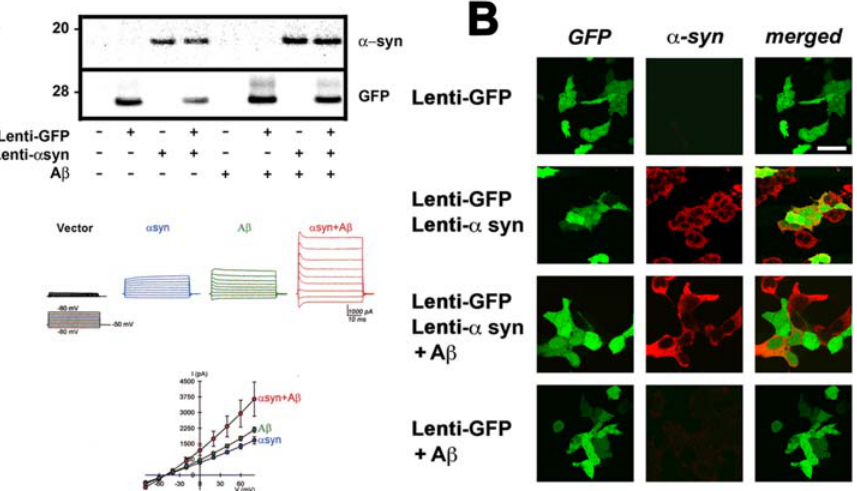
Figure 7. Electrophysiological analysis of the cellular effects of hybrid A b / a -syn multimers. 293T cells were infected with lenti- a -syn and lenti-GFP and treated with A b and analyzed by electrophysiology. ( A ) Immunoblot analysis showing expression levels of a -syn and GFP in treated cultures. ( B ) Immunocytochemical analysis demonstrating high efficiency of infection and co-localization between a -syn and GFP. ( C, D ) Representative currents ( C ) elicited by depolarizing the cells from a holding potential of 2 50 mV to a series of test potentials ranging from 2 80 mV to + 80 mV, and corresponding current voltage-relationship curves ( D ), in a -syn-expressing cells treated with vehicle ( a -syn, n=5), vector-transfected cells treated with A b (A b , n=5), and a -syn-expressing cells treated with A b ( a -syn + A b ,